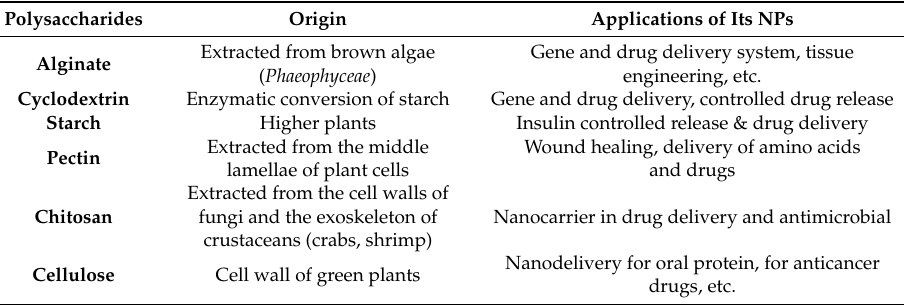
Table 2. Polysaccharides and the applications of their NPs in delivery systems